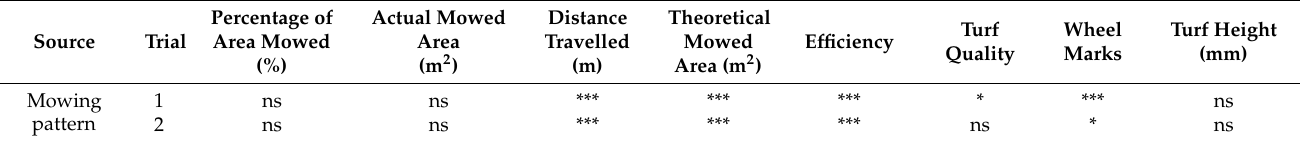
Table 2. Results of analysis of variance testing the effect of mowing patterns on the mowed area percentage, actual mowed area, distance travelled, theoretical mowed area, efficiency, turf quality, wheel marks and turf height. The analysis of variance was carried out separately for the two trials.